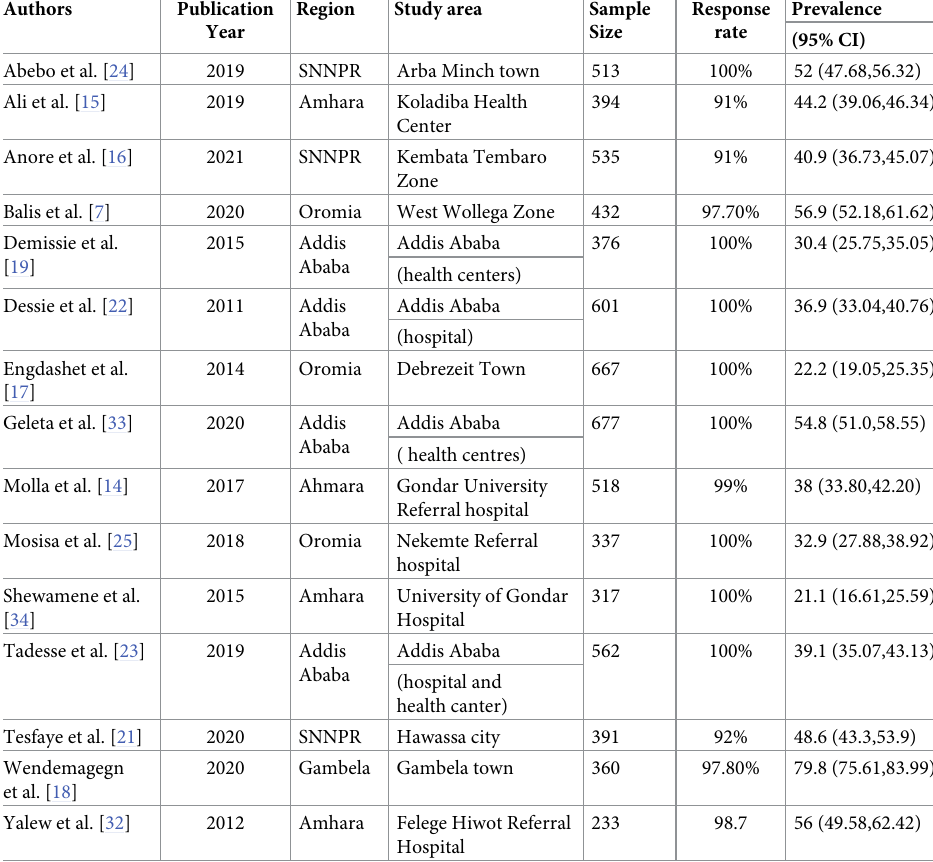
Table 2. Characteristics of the included studies in meta-analysis based on publication year, region, sample size, response rate, and prevalence of the risky sexual practice in Ethiopia, 2021 (n =